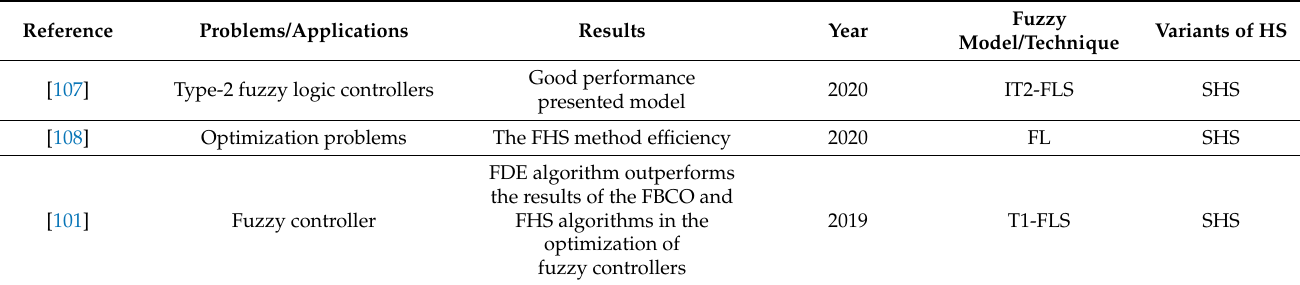
Table 3. A summary of the HS algorithm and fuzzy controller-based